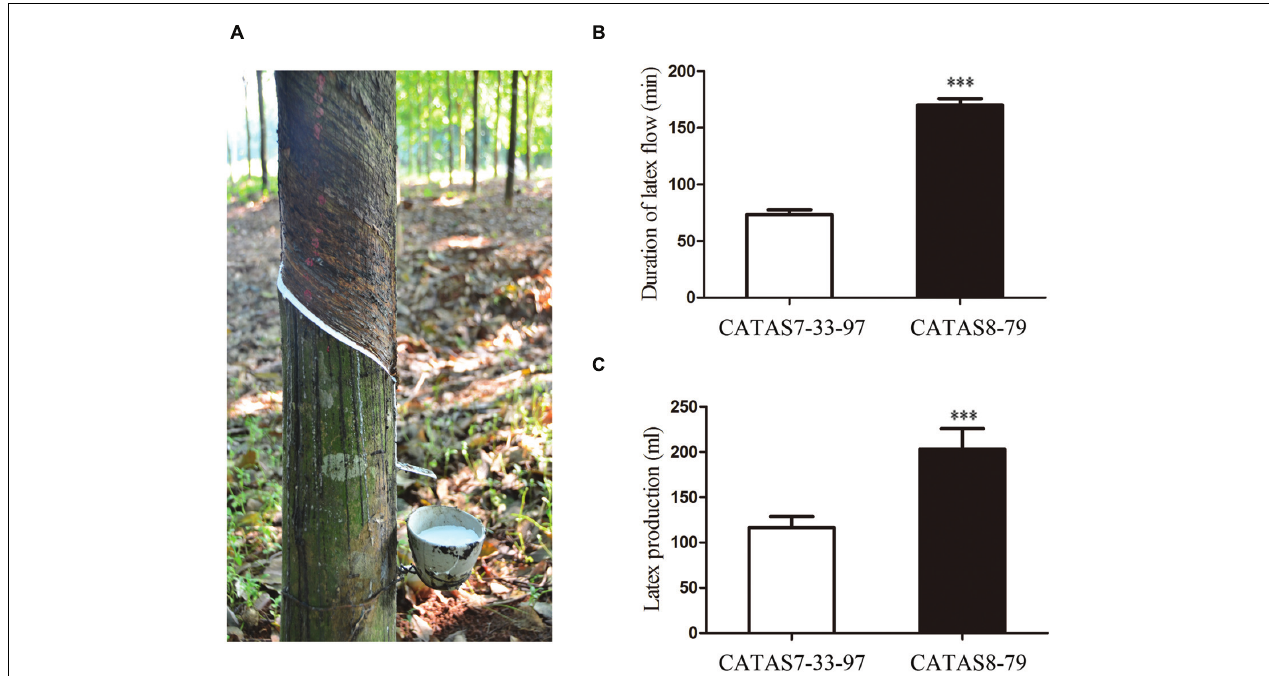
FIGURE 1 | Latex flow of rubber tree (A) and the difference in latex characters (B,C) between CATAS7-33-97 and CATAS8-79. (A) Latex flow of rubber tree after tapping. (B) The difference in duration of latex flow between CATAS7-33-97 and CATAS8-79. (C) The difference in latex production between CATAS7-33-97 and CATAS8-79. Significant difference was indicated by the asterisks above the bars ( ∗∗∗ p < 0.001).